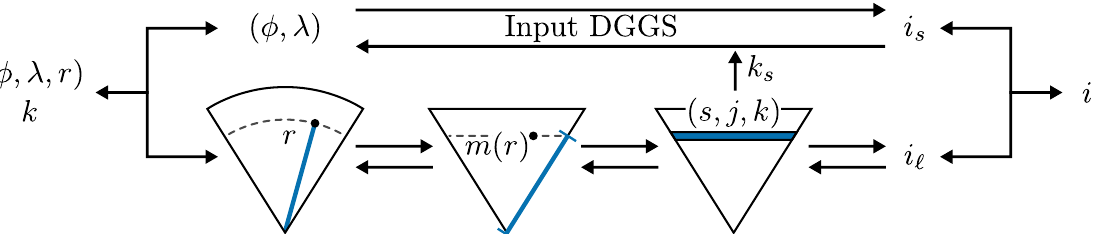
Figure 10. Pipeline for splitting encoding and decoding into surface (top) and radial (bottom) components. These two components are entirely independent except for the surface resolution ( k s ) of the layer being provided to the surface component during encoding. Standard notation for latitude and longitude ( φ and λ ) is